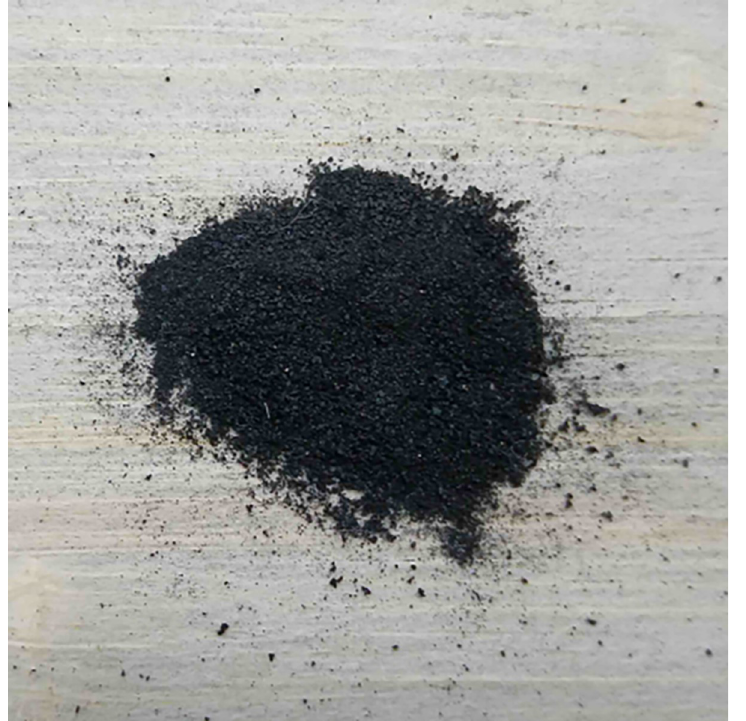
Fig 1. The surface morphology of graphene